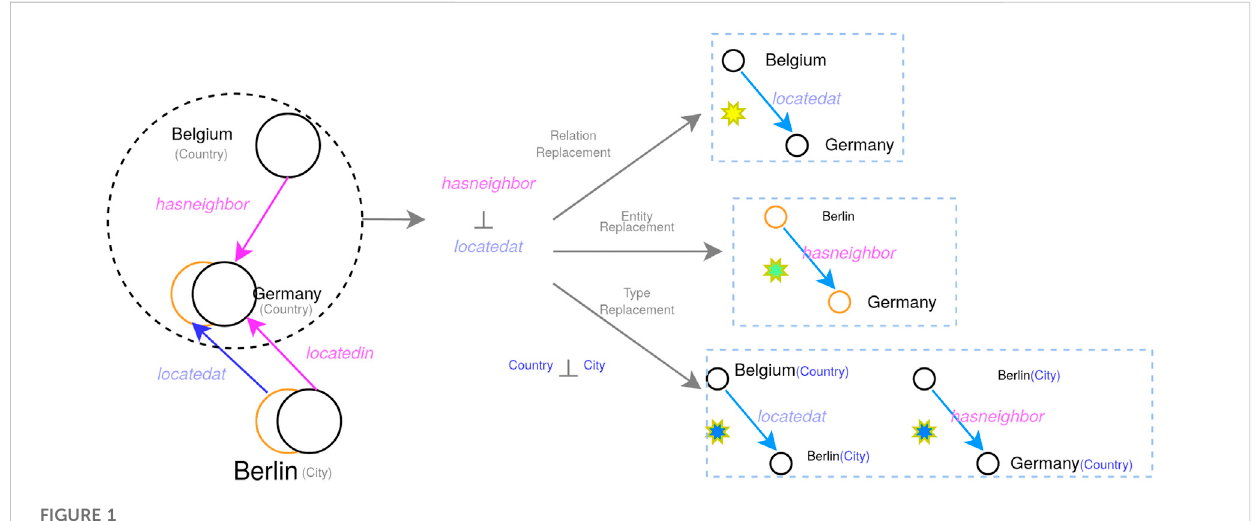
FIGURE 1 Three conditions of cross-KB negative